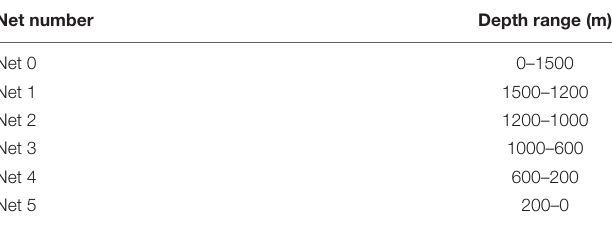
TABLE 1 | Discrete-depth ranges targeted for sampling via MOC10 during both ONSAP and DEEPEND